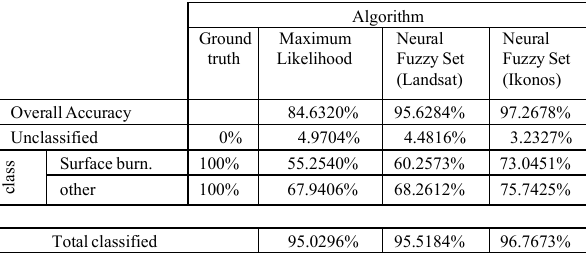
Table 2. Classification results